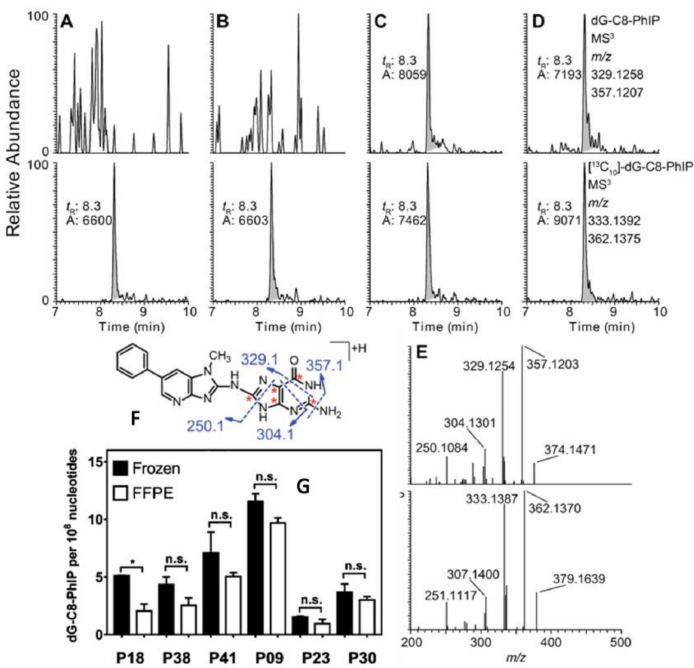
Figure 7. Extracted ion chromatograms of dG-C8-PhIP and 13 C-labeled dG-C8-PhIP of DNA from fresh frozen and FFPE human prostate tissues at the MS 3 scan stage. ( A ) Fresh frozen prostate and ( B ) paired FFPE block of a patient who was negative for dG-C8-PhIP; ( C ) fresh frozen prostate and ( D ) paired FFPE block of a patient who was positive dG-C8-PhIP at MS 3 scan stage. The structure and proposed fragmentation mechanism of aglycone of dG-C8-PhIP are depicted. ( E ) The product ion spectra at MS 3 of unlabeled and 13 C-labeled dG-C8-PhIP are shown. ( F ) Levels of dG-C8-PhIP in paired fresh frozen prostate and FFPE blocks of six patients are shown in ( G ). The levels of adducts are reported